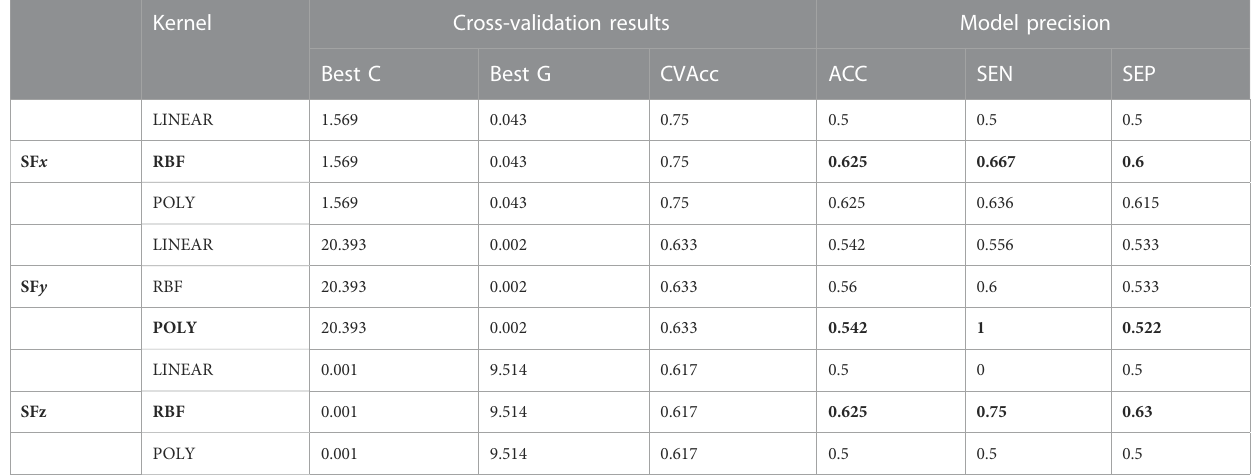
TABLE 3 Comparison of results from the different SVM classi fi cation algorithms designed for SVM models of SFx, SFy, and SFz before and after the Running- induced Fatigue Protocol Test. Note: The best kernel type is highlighted in bold, SFx: medial-lateral direction of SF, SFy: anterior-posterior direction of SF, SFz: vertical direction of